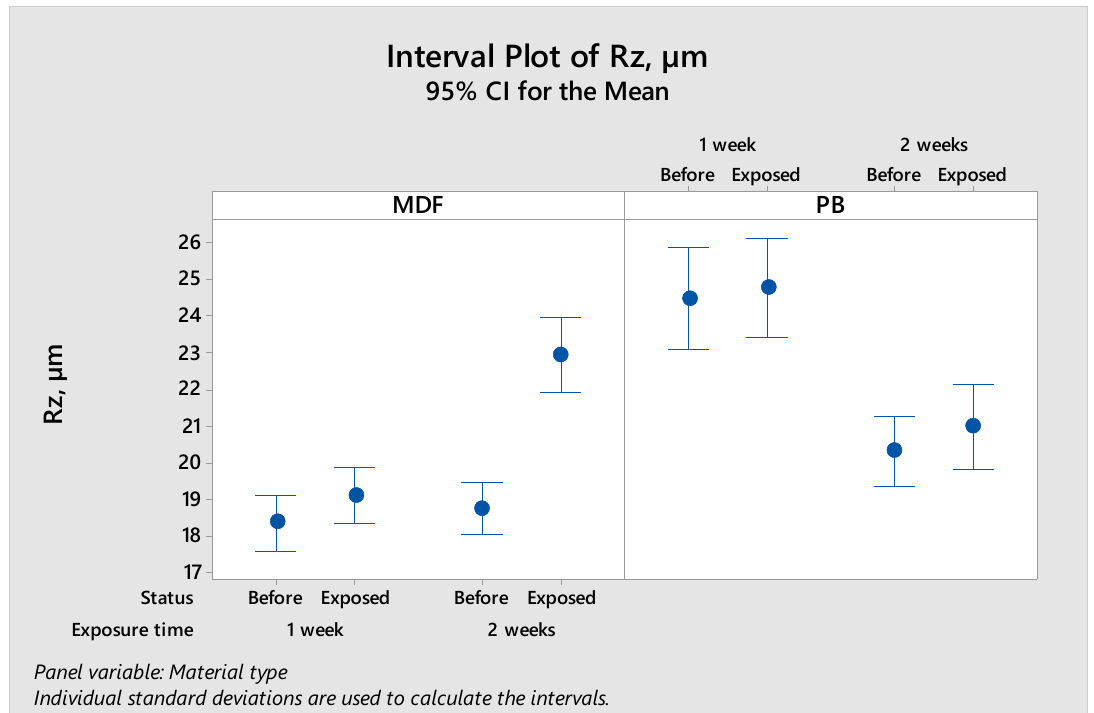
Interval Plot of Ra, µm 95% CI for the Mean